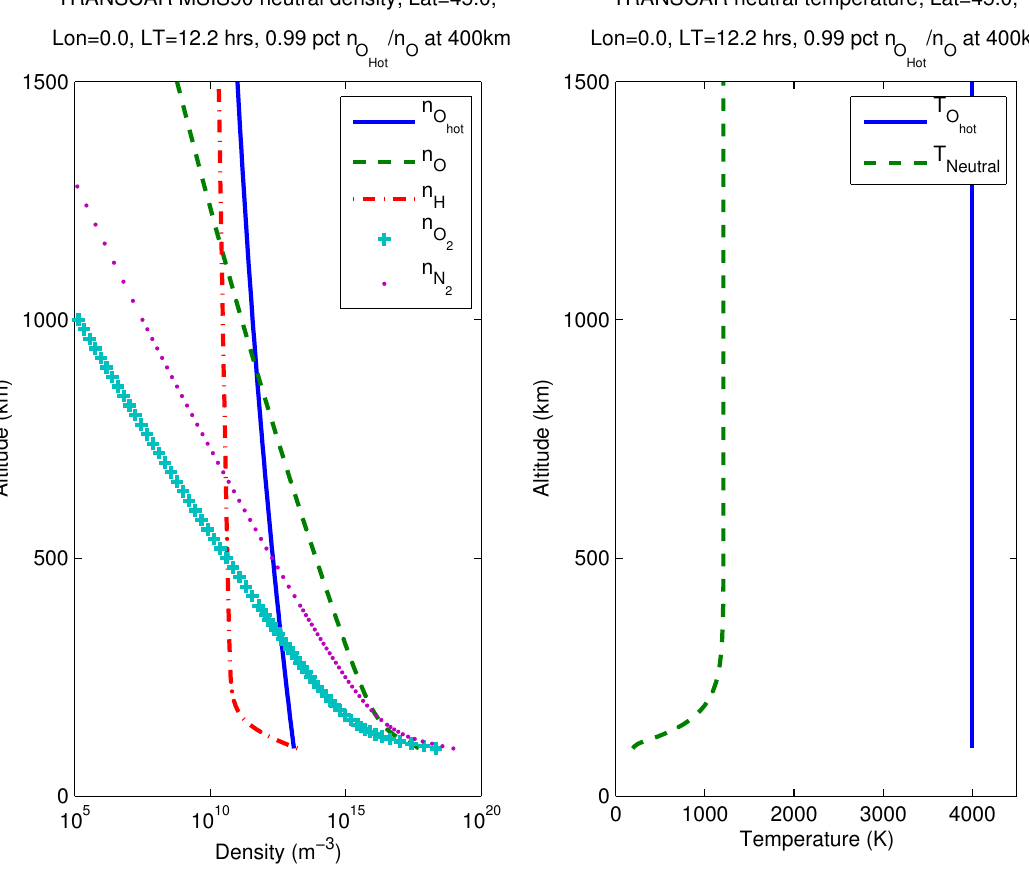
Fig. 2. The neutral atmosphere from TRANSCAR. n s is the number density for species s . T O Fig. 2. The Neutral Atmosphere From TRANSCAR. n s is the number density for species s . T O other neutral particle temperatures from the MSIS the other neutral particle temperatures from the MSIS model.